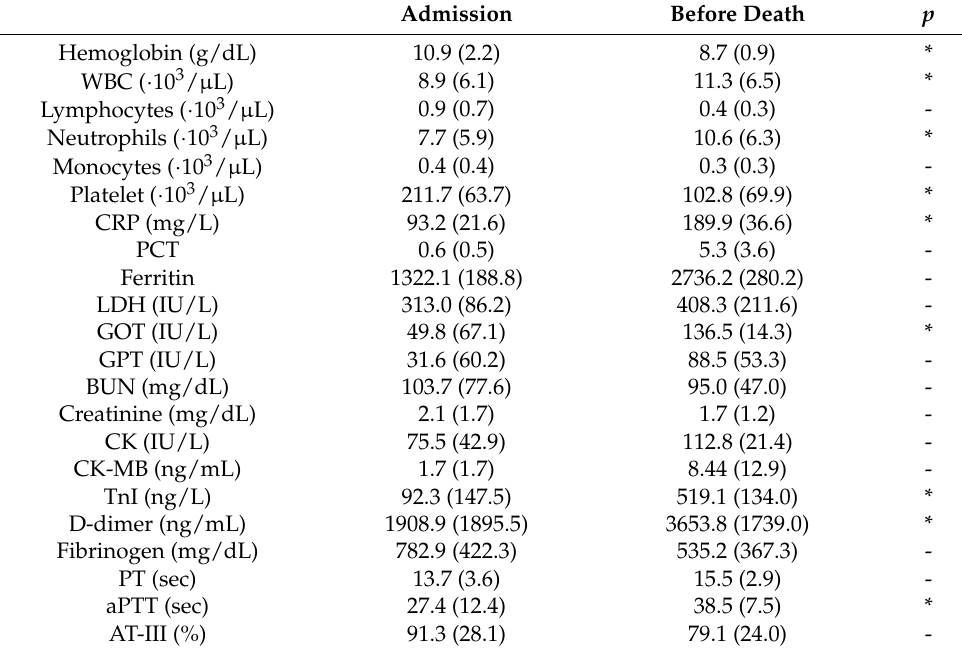
Table 2. Blood test results at baseline and before